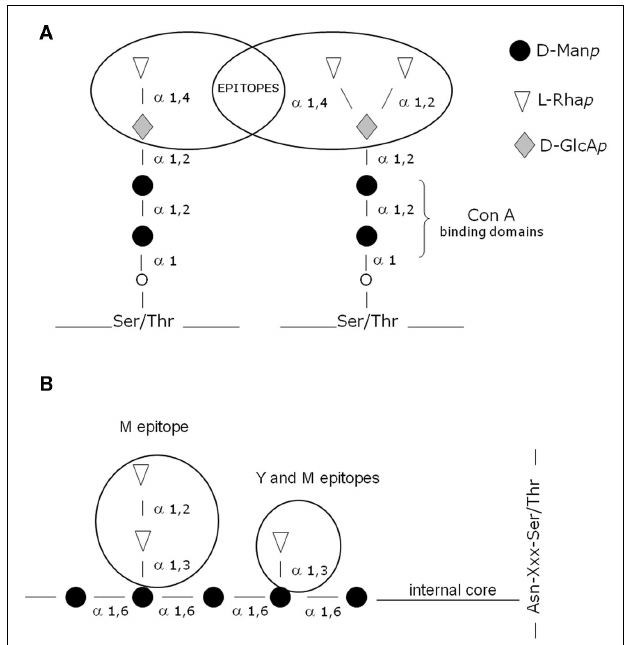
FIGURE 1 | (A,B) Schematic representation showing the general structure of the main antigenic epitopes and ConA-binding sites described on the cell wall peptidorhamonomannan of both the yeast (Y) and mycelial (M) phases of S. schenckii .